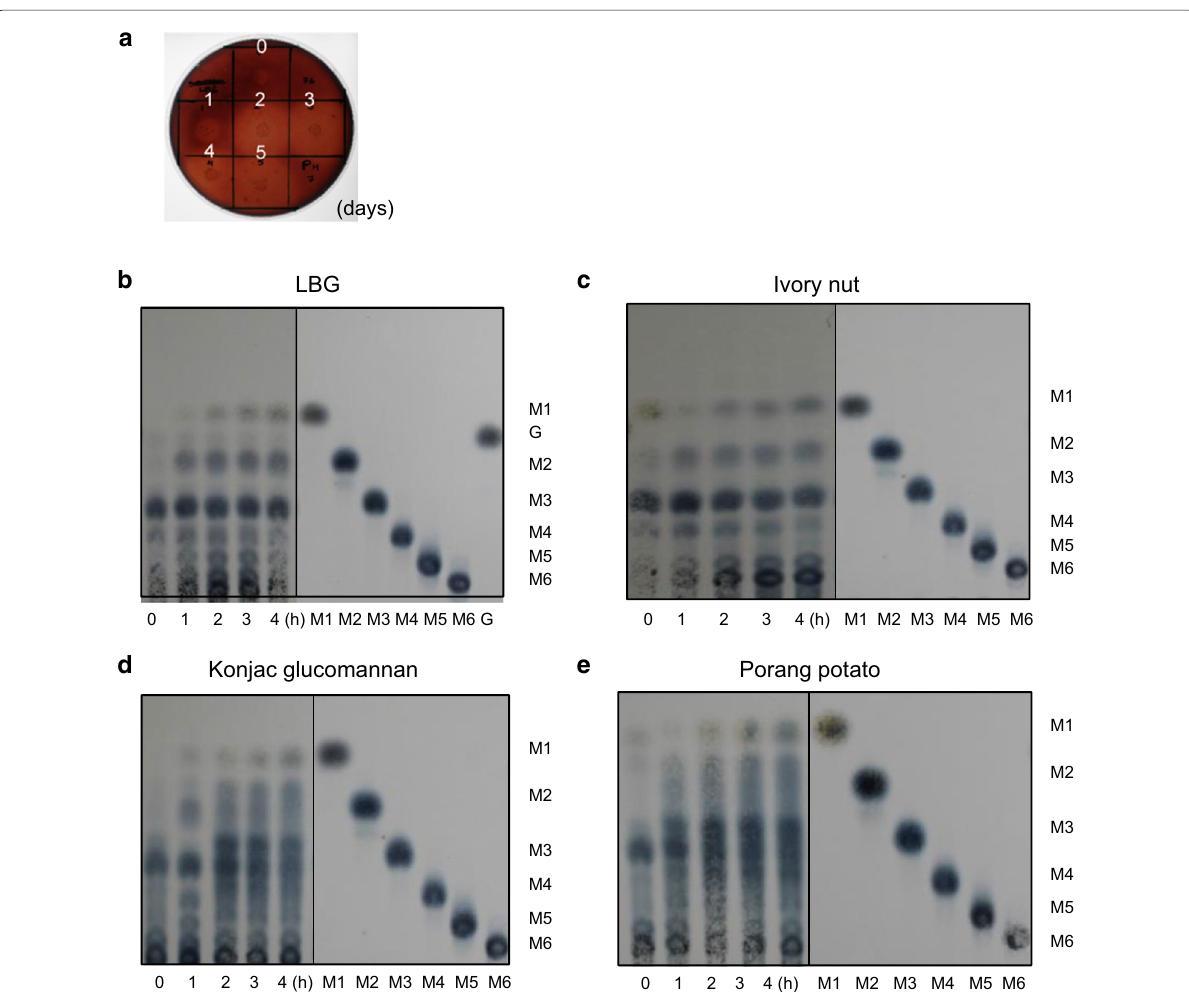
Fig. 1 a Clear zone on LBG agar medium at pH 7.0 using culture supernatant of ID04‑0555 strain, indicating hydrolysis of β‑mannanase (0, 1, 2, 3, 4, and 5 day cultivation). b – e TLC analysis of hydrolysis products from various mannan substrates using secreted mannan degradation enzymes of ID04‑0555, b LBG, c ivory nut, d konjac glucomannan, and e porang potato. Standards (STD), mannose (M1), mannobiose (M2), mannotriose (M3), mannotetraose (M4), mannopentaose (M5), mannohexaose (M6), and galactose